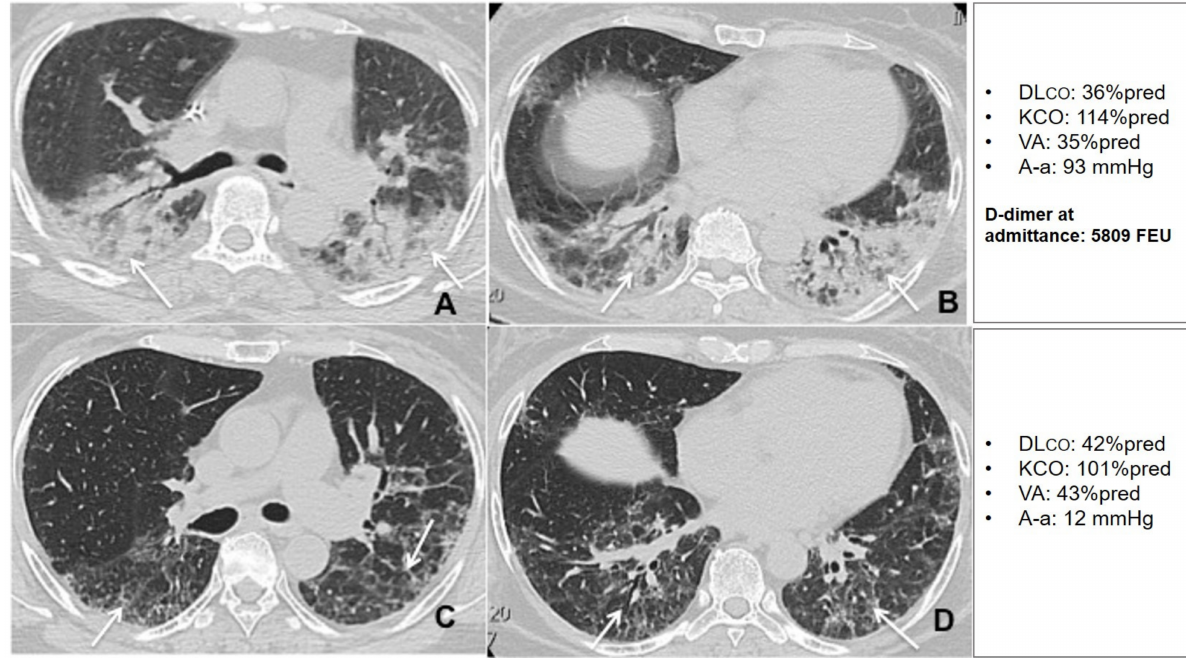
Figure 8. Unenhanced thin section axial ( A , B ) CT images of the lungs obtained the 12th day post-admission in a 57-year-old woman with arterial hypertension and no previous exposure to cigarette smoke, that was admitted to the HDRU with a PaO 2 /FiO 2 of 210 mmHg, rapidly worsened her respiratory status and needed invasive mechanical support for 8 days. The images show peripheral posterior GGO and consolidations in both lungs, with predilection for posterior areas (arrows). Unenhanced axial ( C , D ) CT images of the same patient 6 weeks post-discharge show residual interlobular septal thickening with intralobular lines (arrows) with resolution of previous GGO and consolidation. The patient had a high D-dimer at admission and showed very limited changes in DLco during the recovery